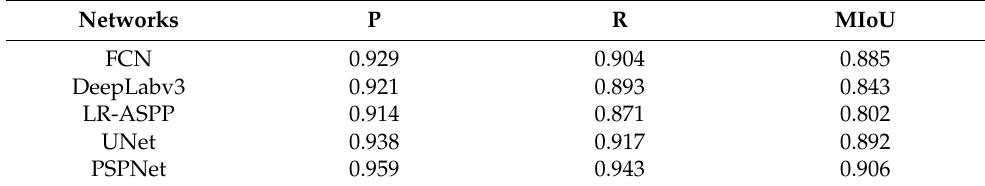
Table 5. Comparison results of PSPNet and other networks.